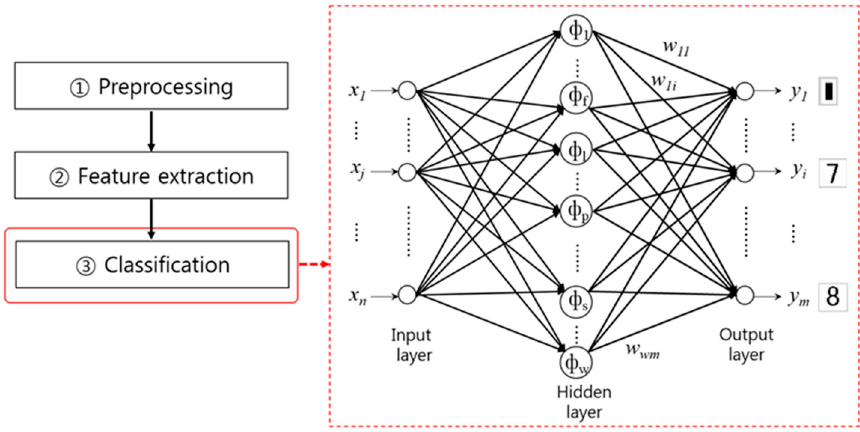
Figure 20. Example of NN-based classification in the serial number recognition process step.